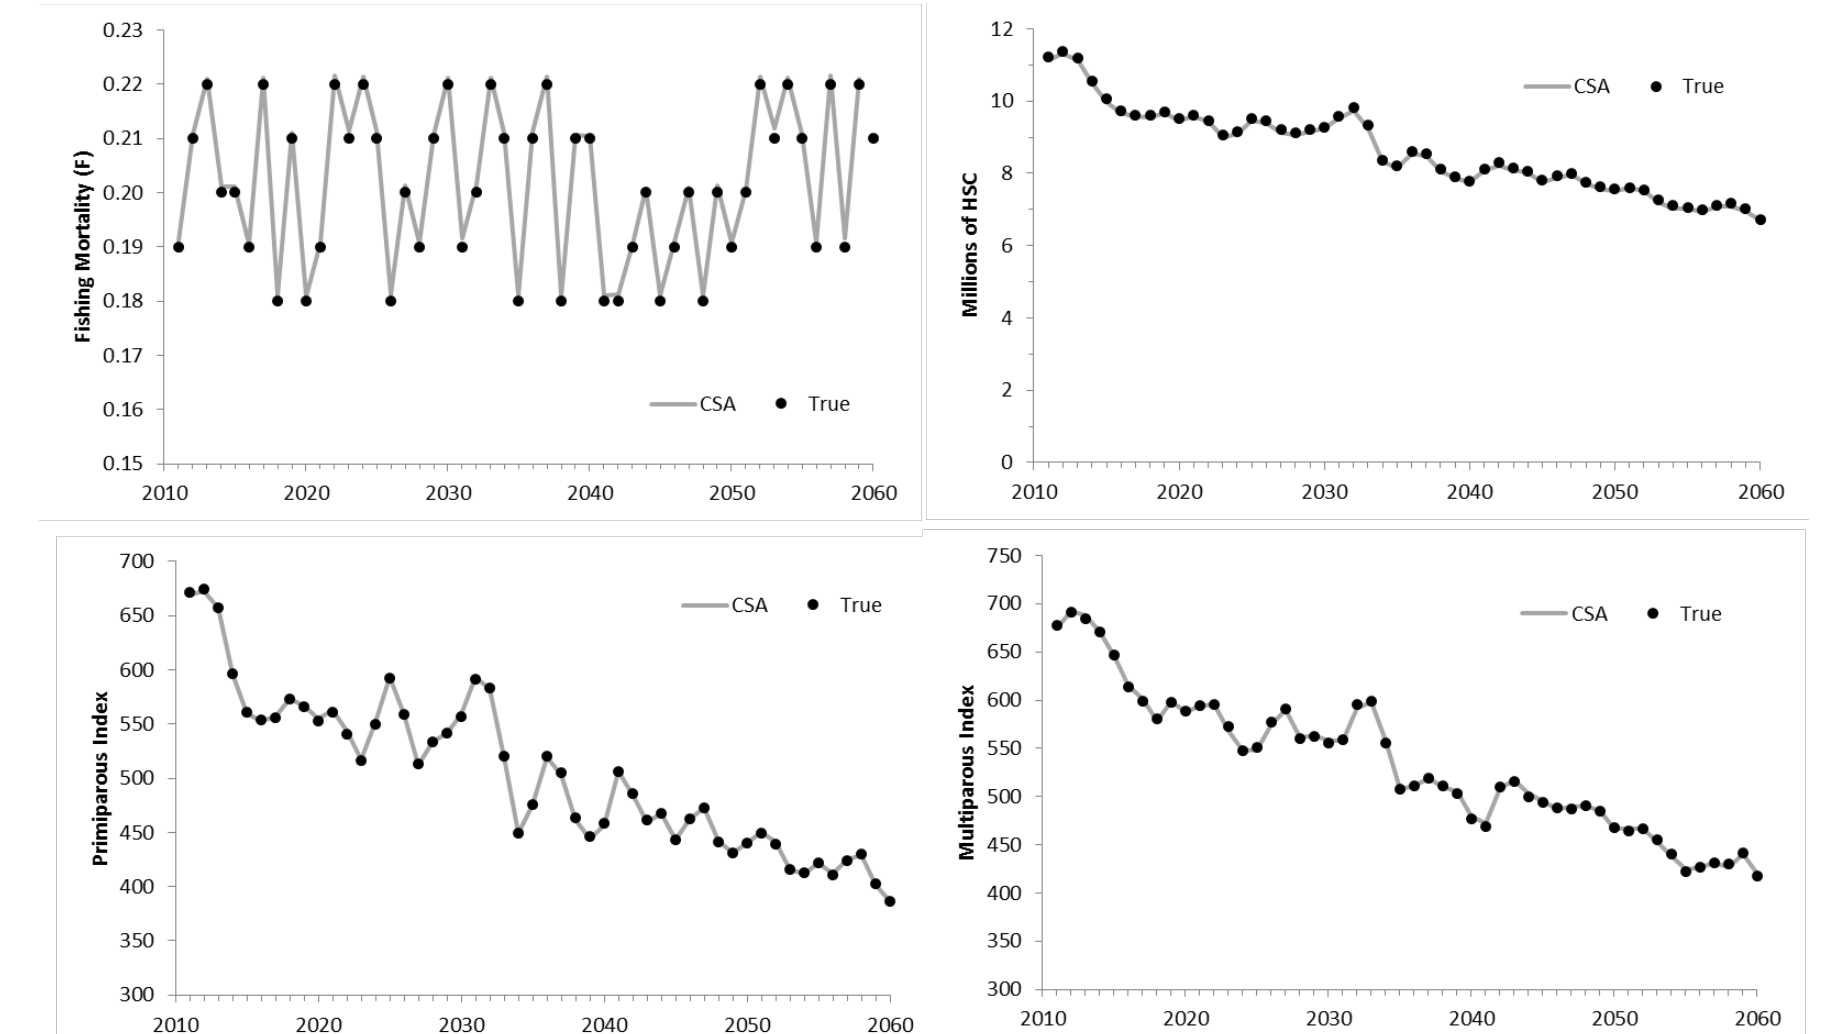
Figure 98. Comparison between simulated “true” data from the operating model and catch survey analysis (CSA) results for simulation